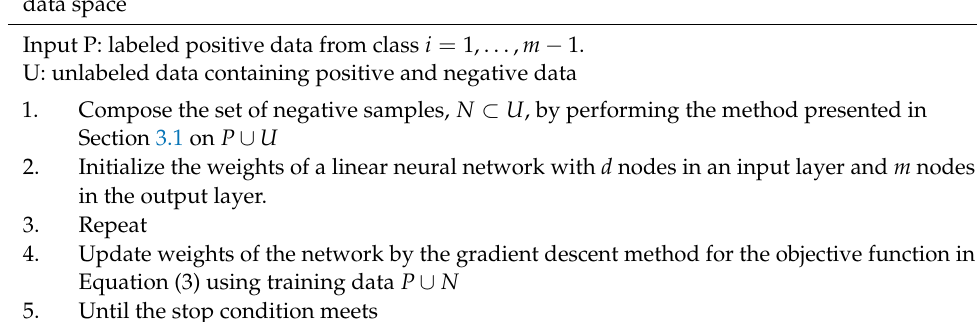
Algorithm 2. The proposed MPU learning algorithm based on outlier detection in the original data